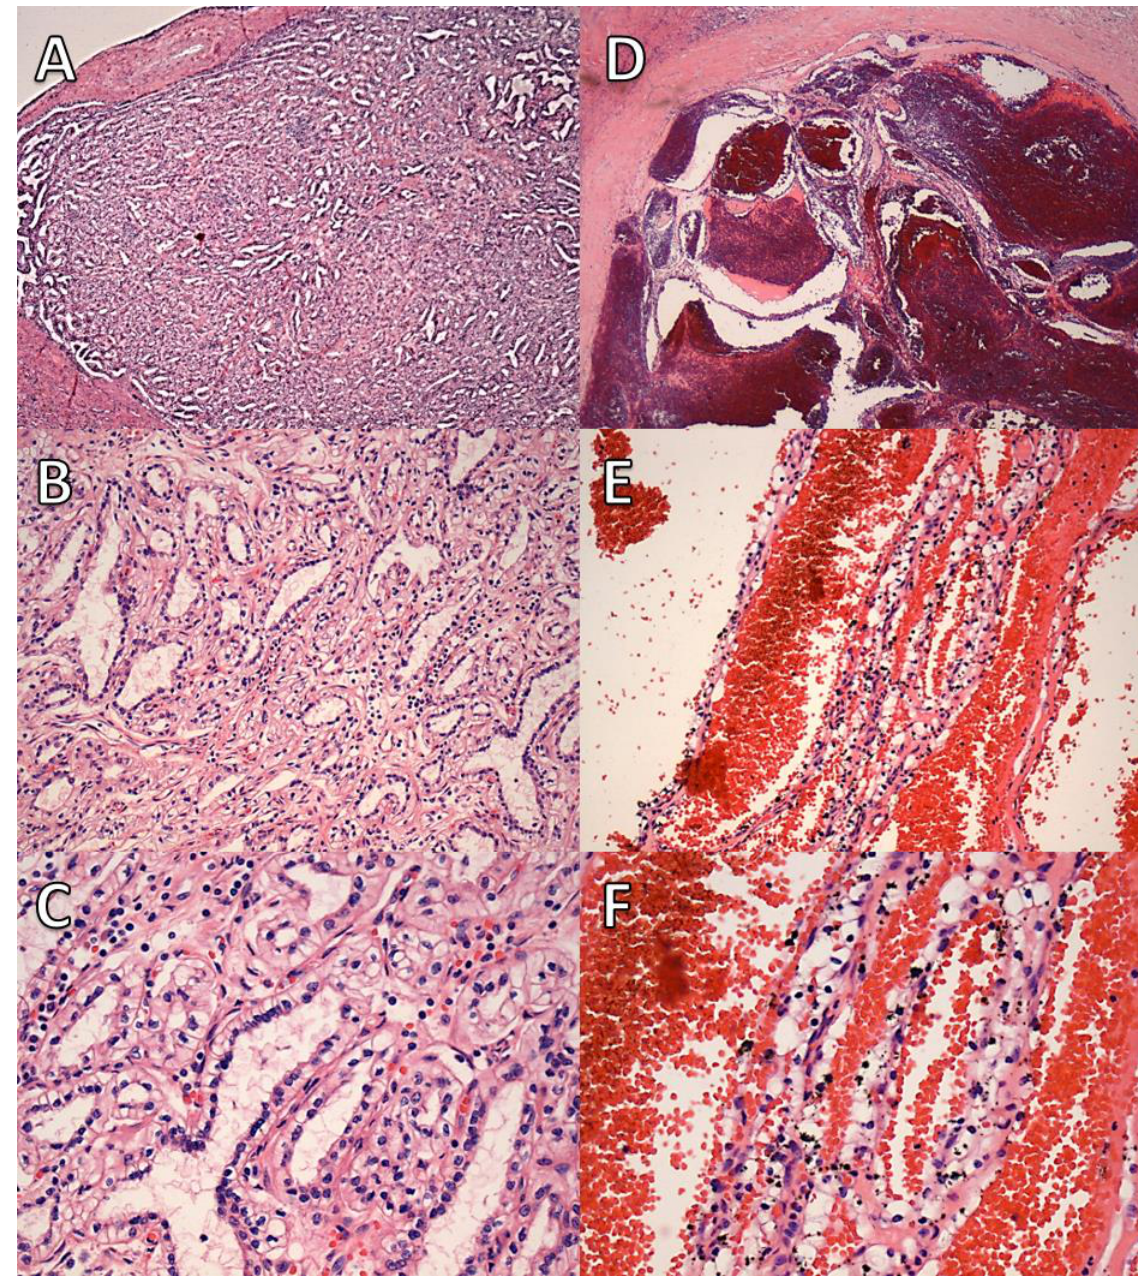
Figure 5. Case 2: A-C . Clear-cell tubulopapillary renal cell carcinoma. D-F . Multilocular cystic renal neoplasm of low malignant